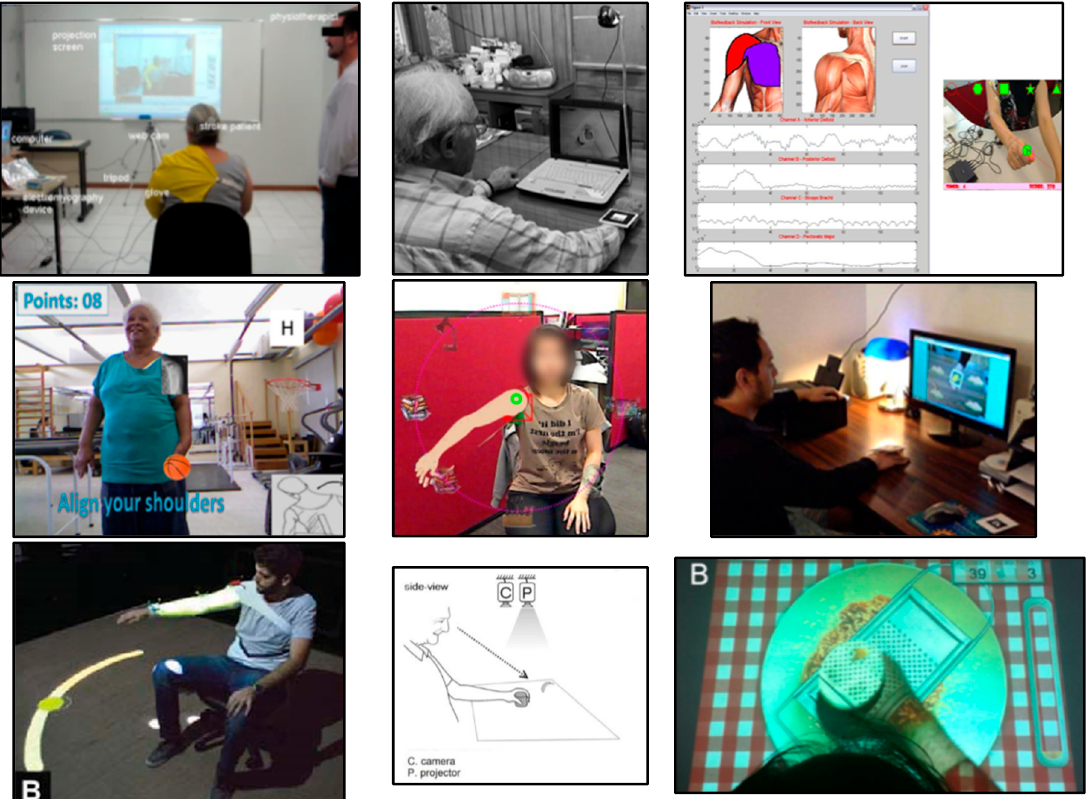
Figure 1. The nine AR Rehab Systems: NeuroR (top-left), ARS (top-center), RehaBio (top-right), MirrARbilitation (middle-left), ARIS (middle-center), AR Games by De Leon et al. (middle-right), SleeveAR (bottom-left), AR Fruit Ninja (bottom-center), and AR System by Colomer et al. (bottom-right) [18–29] .